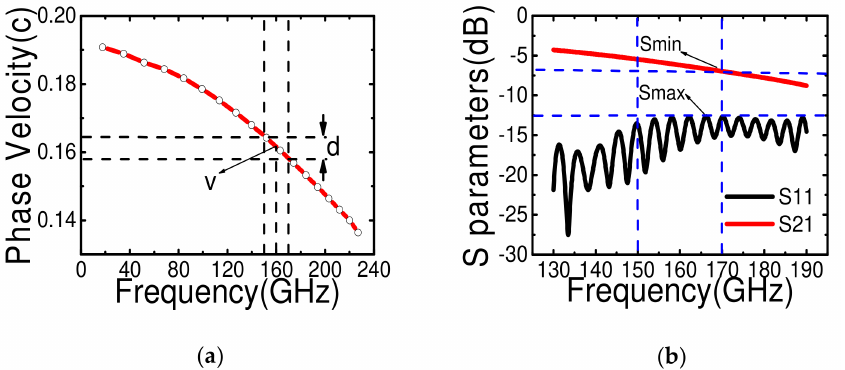
Figure 2. Cold-test characteristic of the MML structure: ( a ) Dispersion characteristic; ( b ) Transmission (S21) and reflection